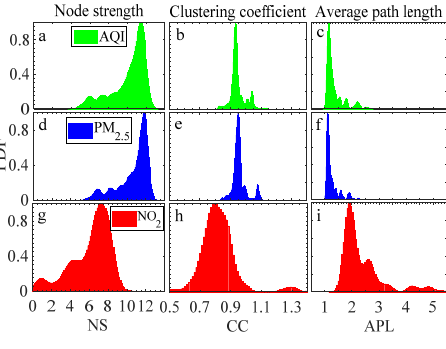
Figure 4. PDF of node strength (the first column), clustering coefficient (the second column), and average path length (the third column) for three indexes of AQI (the first row), PM 2.5 (the second row) and NO 2 (the third row). There is a similar shape of the PDF between the AQI and PM 2.5 , while a significant difference can be observed between them and that of NO 2 . The right panel shows the J-S divergence of the PDF of the clustering coefficient, node strength, and average path length of the AQI series and the two pollutants’ series for the 14 cities at different time